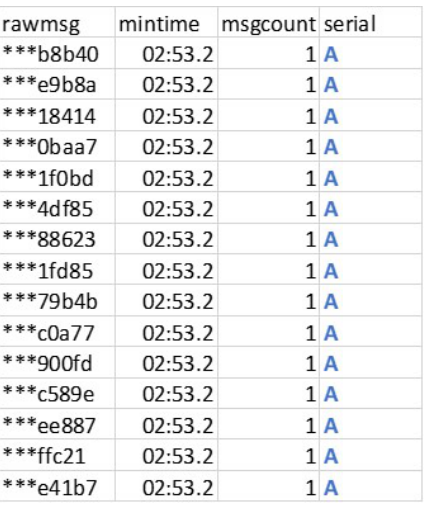
Figure 7. Sample data of receiver with incorrect timestamp.